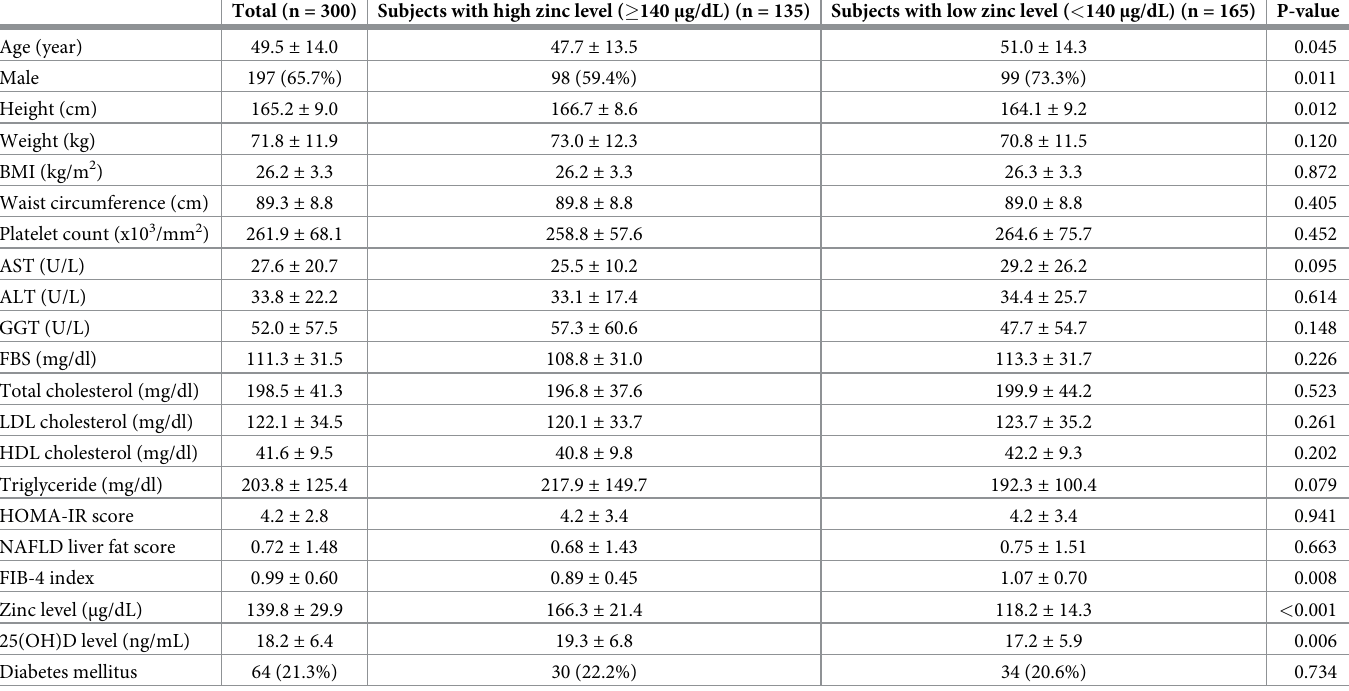
Table 1. Baseline characteristics of the subjects with